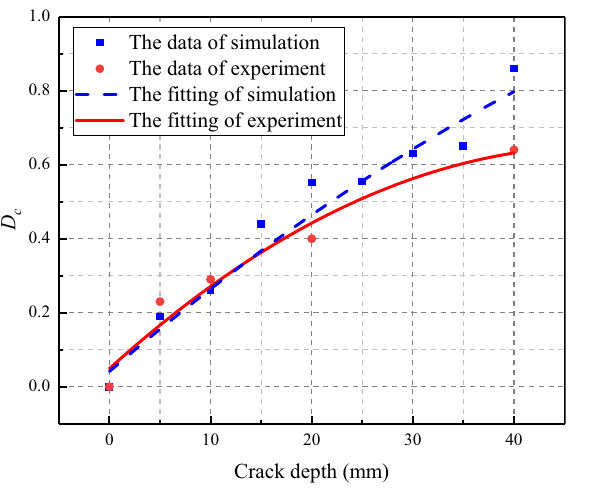
Figure 15. The degree of crack ( D c